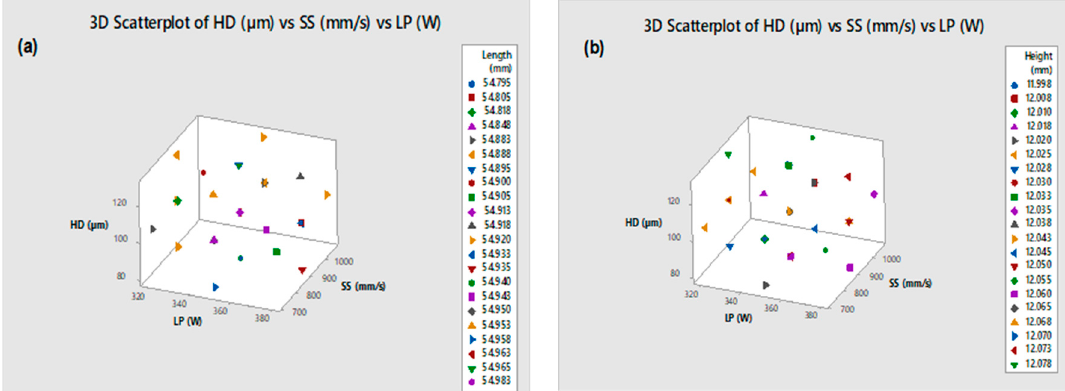
Figure 6. All plot parameter effects for ( a ) length and ( b ) height.